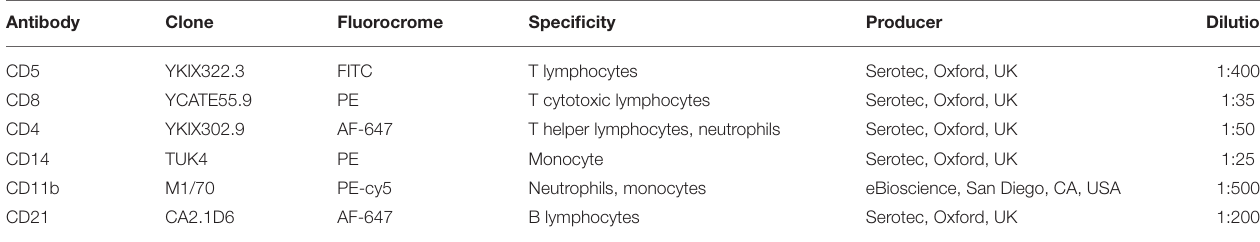
TABLE 1 | List of the antibodies in use, their specificity and dilution.